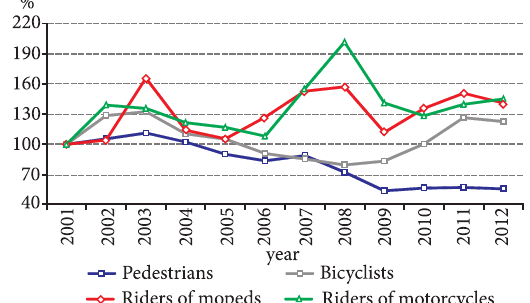
Fig. 4. Percentage changes of accidents in 2011–2012